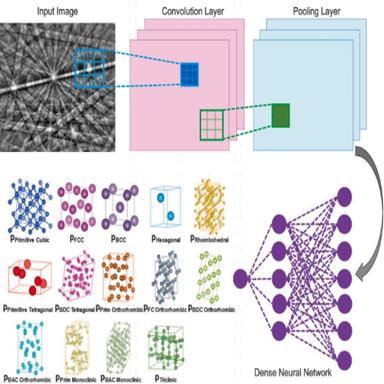
Illustration of the inner workings of a convolutional neural network applied to EBSD. Convolutional neural networks (CNNs) are composed of a series of alternating convolutional and pooling layers. Each convolutional layer extracts features from its preceding layer, using filters (or kernels) learned from training the model, to form feature maps. These feature maps are then down sampled by a pooling layer to exploit data locality. A traditional dense neural network, a simple type of classification network, i